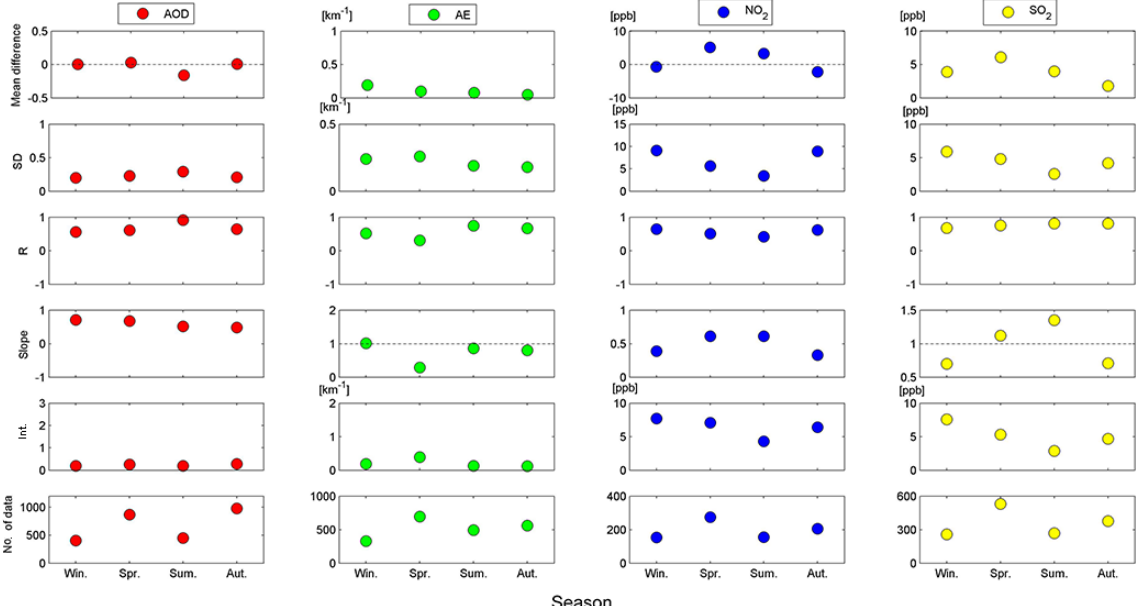
Figure 6. Mean absolute differences and standard deviations as well as correlation coefficients ( R ), slopes and intercepts derived from linear regressions of the AODs, and near-surface AE, NO 2 and SO 2 VMRs between MAX-DOAS and independent techniques for different seasons for clear-sky conditions with low aerosol loads. The corresponding number of data points is shown in the bottom panel. Different colours denote AOD (compared with the Taihu AERONET level 1.5 data sets), AE (compared with the nearby visibility meter) and NO 2 and SO 2 (compared with the nearby long-path DOAS instrument). For calculations of mean absolute differences, the data derived from independent techniques are subtracted from those derived from the MAX-DOAS instrument. The data derived from the MAX-DOAS instrument are plotted against those derived from independent techniques for linear